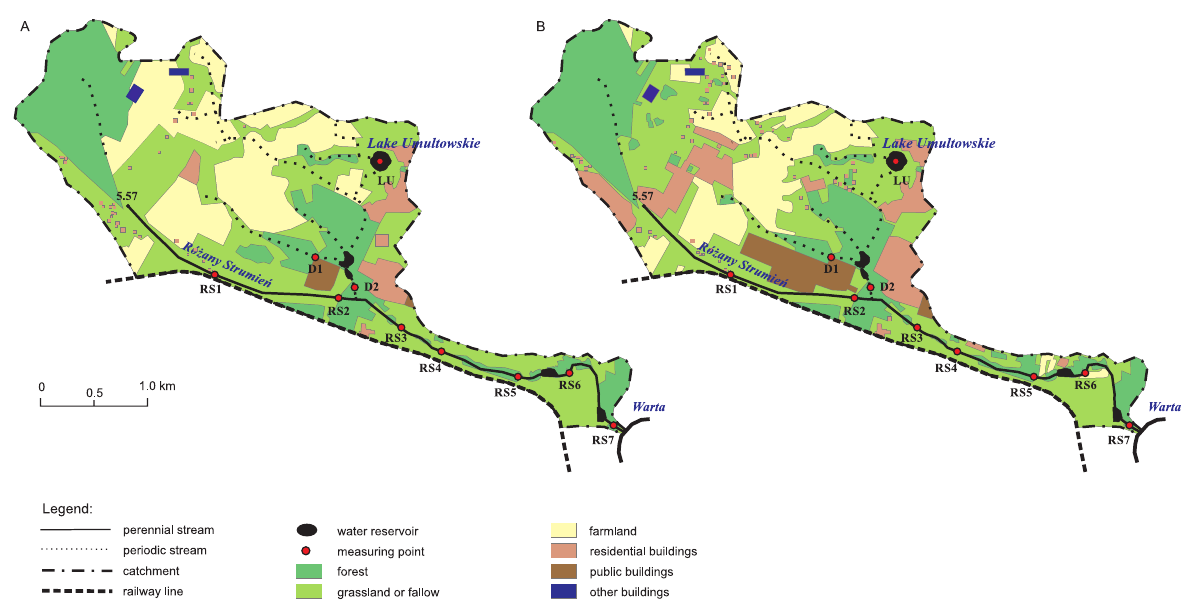
Fig. 5. land development of the catchment in 2003 (A) and in 2013 (B) (following Mapa Sozologiczna Polski w skali 1:50000 2004, GUGiK